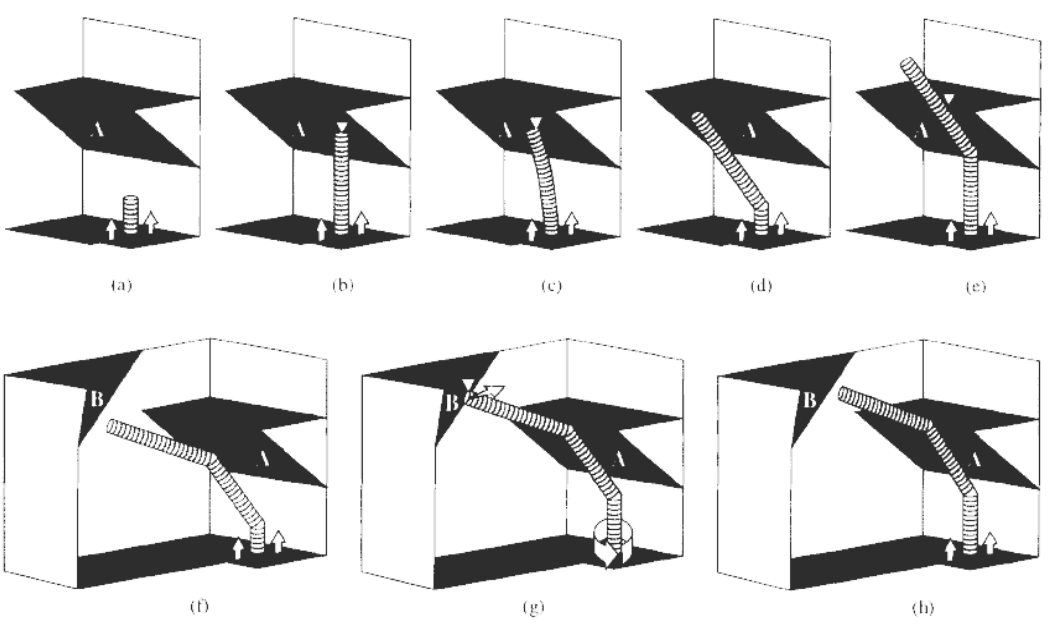
Figure 12. Explanation of the growth mechanism leading to tori (a)-(e) and to helices (a)- (h). (a) Growing nanotubule on an immobilized catalyst particle; (b) the tube reaches obstacle A; (c) elastic bending of the growing tubule caused by its blockage at the obstacle A; (d) after the formation of the knee, a second growing stage can occur; (e) second blockage of the growing nanotubule by the obstacle A; (f) after the formation of the second knee, a new growing stage can occur; (g) the tube reaches obstacle B; (h) formation of the regular helicity in the growing tubules by the obstacle B. Reproduced from [33] with